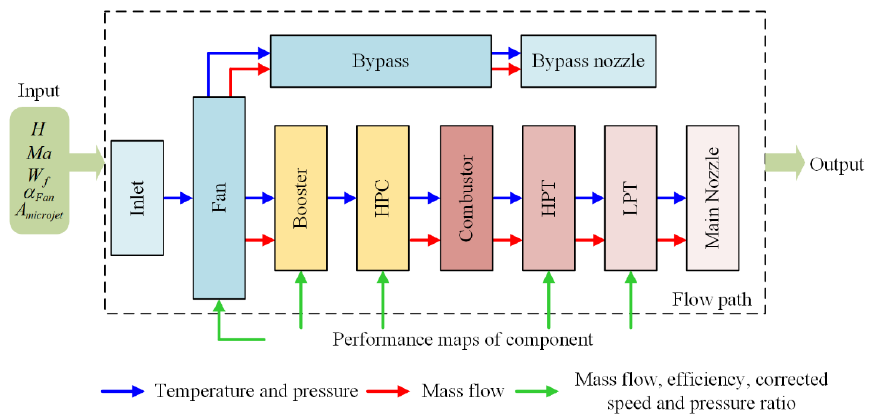
Figure 3. Schematic diagram of computational interaction of turbofan engine model.